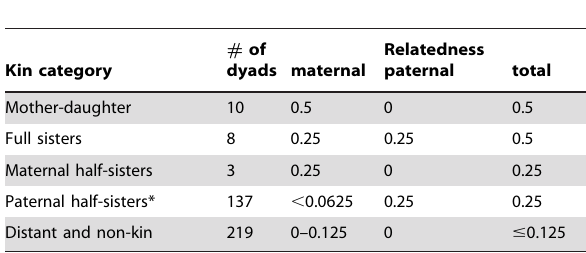
Table 1. Kin category, number of dyads in the group and their relatedness coefficients used in this study.